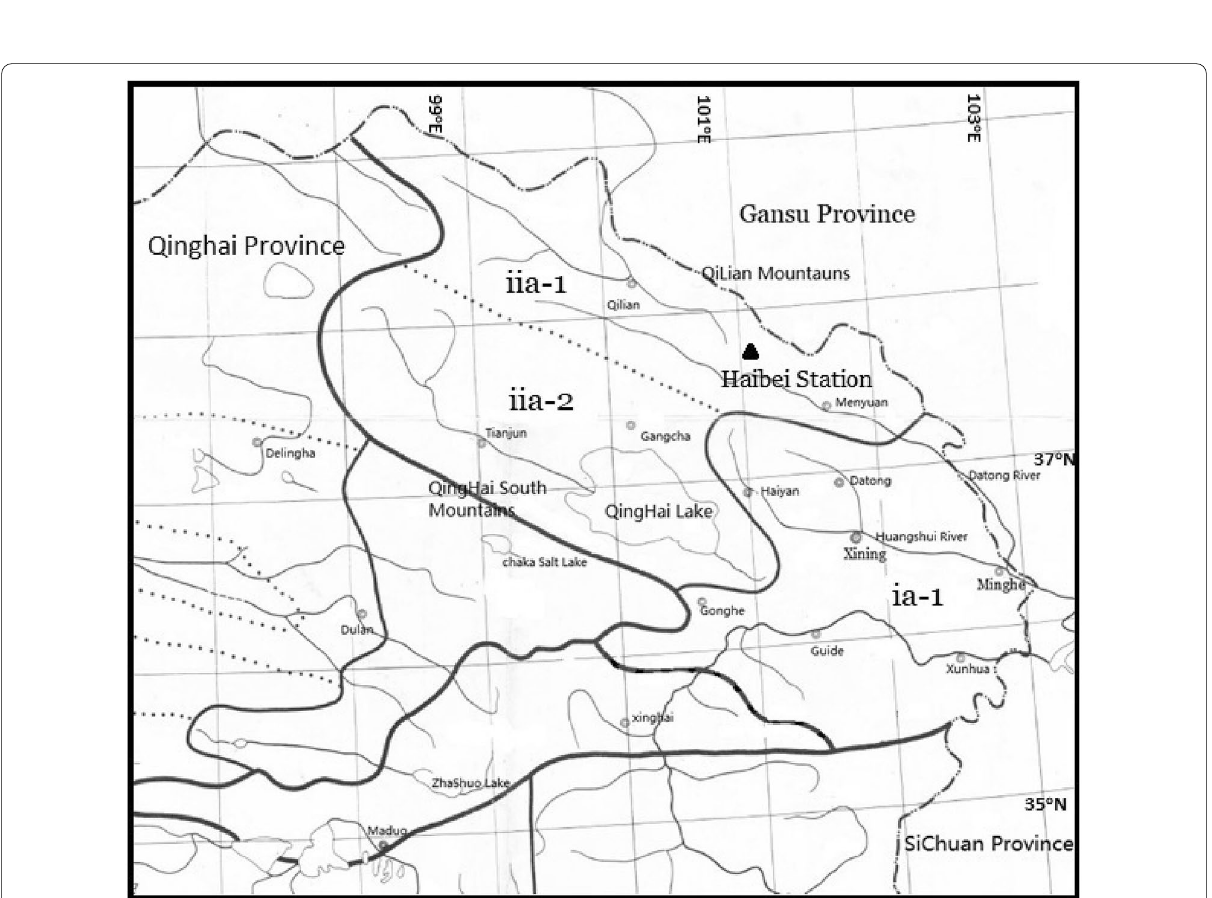
Fig. 6 Using Biogeoclimatic condition, generated lower levels of ECL under HIIC1 Section in the North Eastern Qinghai Province in